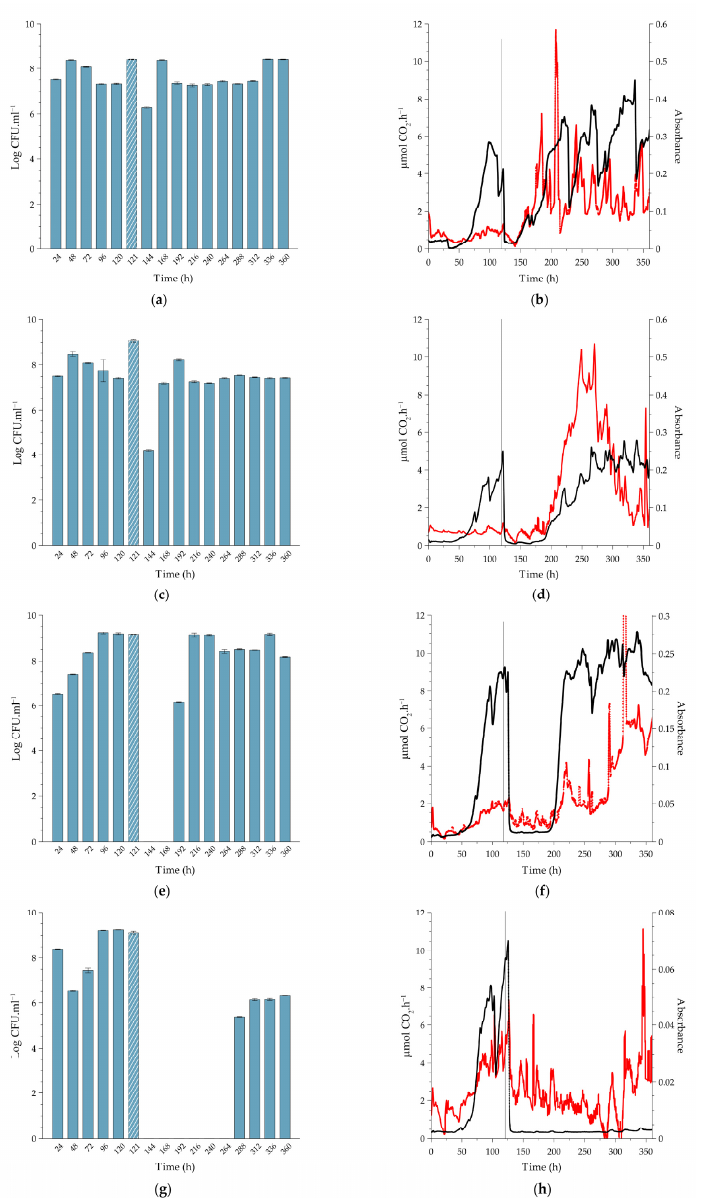
Figure 3. Sessile growth of L. monocytogenes serovar 1 / 2 a EGDe at 10 ◦ C, exposed to a single (slug) dose of peracetic acid (PAA) for a 20-min period under continuous flow conditions. The biofilms were cultivated in the combined CEMS-BioSpec system on 10% BHI. Planktonic cell yields from sessile communities were determined before and after dosing with increasing concentrations of PAA; ( a ) 0.16% PAA (MIC), ( c ) 0.5% PAA (minimum recommended concentration), ( e ) 1.5% PAA (10-fold increase from MIC) and ( g ) 4.0% PAA (maximum recommended concentration). Crosshatched bars represent planktonic cell yields 1 h after PAA dosing (121 h) of the sessile communities. Each bar represents the logged mean of triple plate counts, with the error bar representing the standard deviation. All data are representative of biological duplicates. Changes in biofilm metabolic activity (black line) and biofilm biomass (red line) were monitored in real-time. The introduction of PAA into the system at 120 h is indicated by a vertical grey line. Biofilms were dosed with increasing concentrations of PAA; ( b ) 0.16% PAA (MIC), ( d ) 0.5% PAA (minimum manufacturer recommended concentration), ( f ) 1.5% PAA (10-fold increase of MIC), and ( h ) 4.0% PAA (maximum manufacturer recommended concentration). Figure 3b,d,f,h are representative data from duplicate biofilms. Each bar in Figure 3a,c,e,g represents the average of triplicate plate counts of duplicate biofilms, and error bars indicate the standard